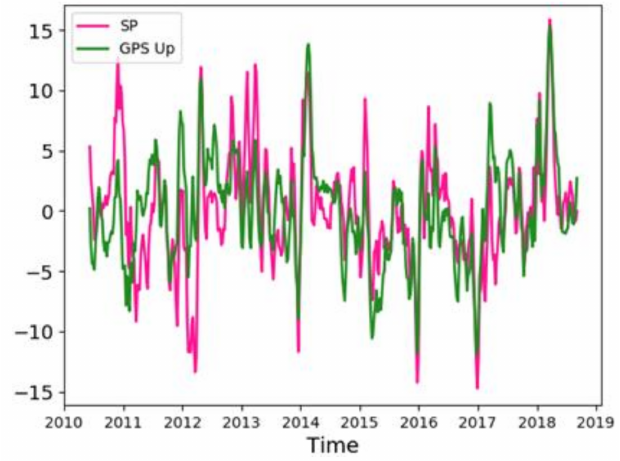
Figure 9. Time components of the first SVD of the residuals of the variable pair (monthly values) SP (magenta line) and Up coordinate (green line).